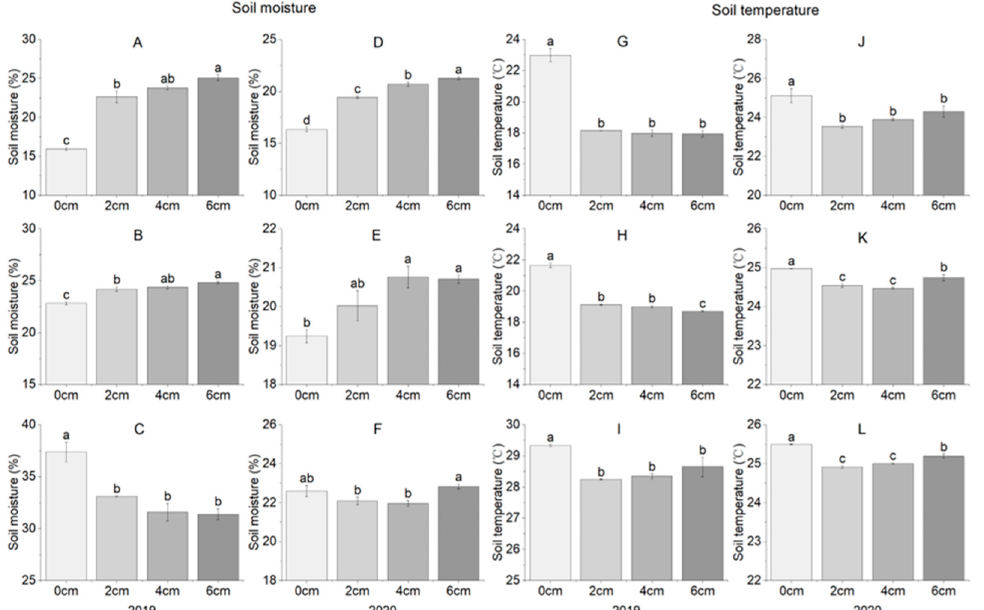
Figure 2. The effects of different treatments on soil moisture and temperature. ( A )–( F ) represent the average soil moisture ± standard error of 0 cm, 2 cm, 4 cm and 6 cm straw mulching treatments in different stages in 2019 and 2020. ( G )–( L ) represent the average soil temperature ± standard error of 0 cm, 2 cm, 4 cm and 6 cm straw mulching treatments in different stages in 2019 and 2020 (the soil moisture and temperature were measured in 7 cm depth under soil surface, n = 3, p < 0.05).